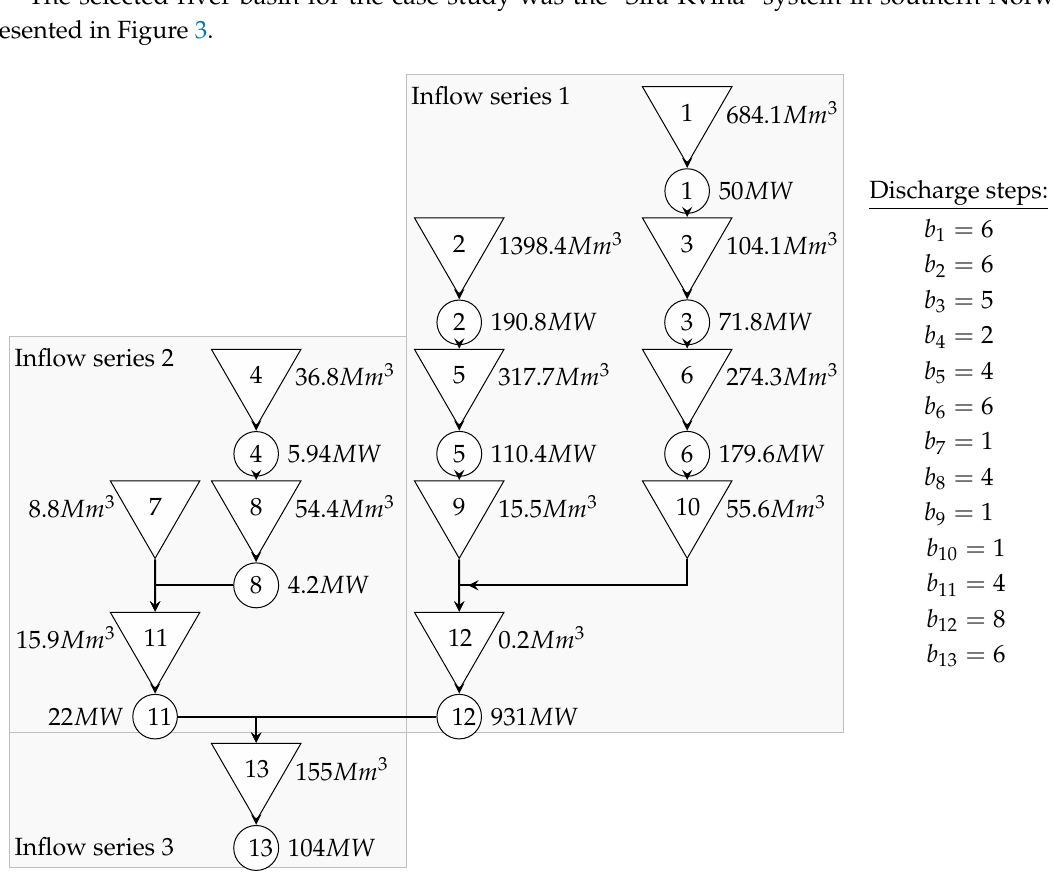
Figure 3. Sira Kvina river